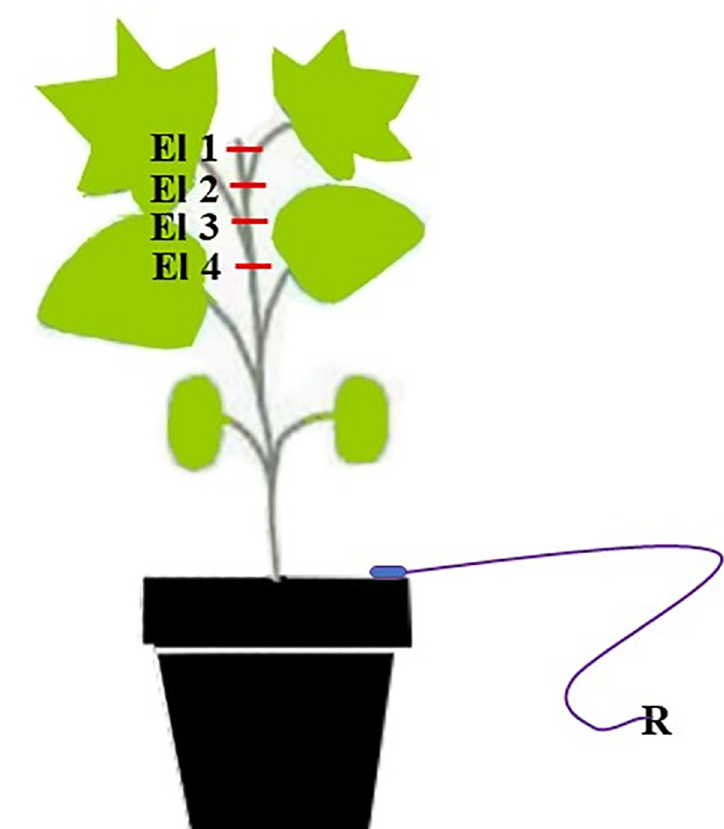
Fig 1. Scheme of the electrodes (El, E2, E3 and E4) in the cotton plant inserted into the stem; and R (reference electrode) inserted into the